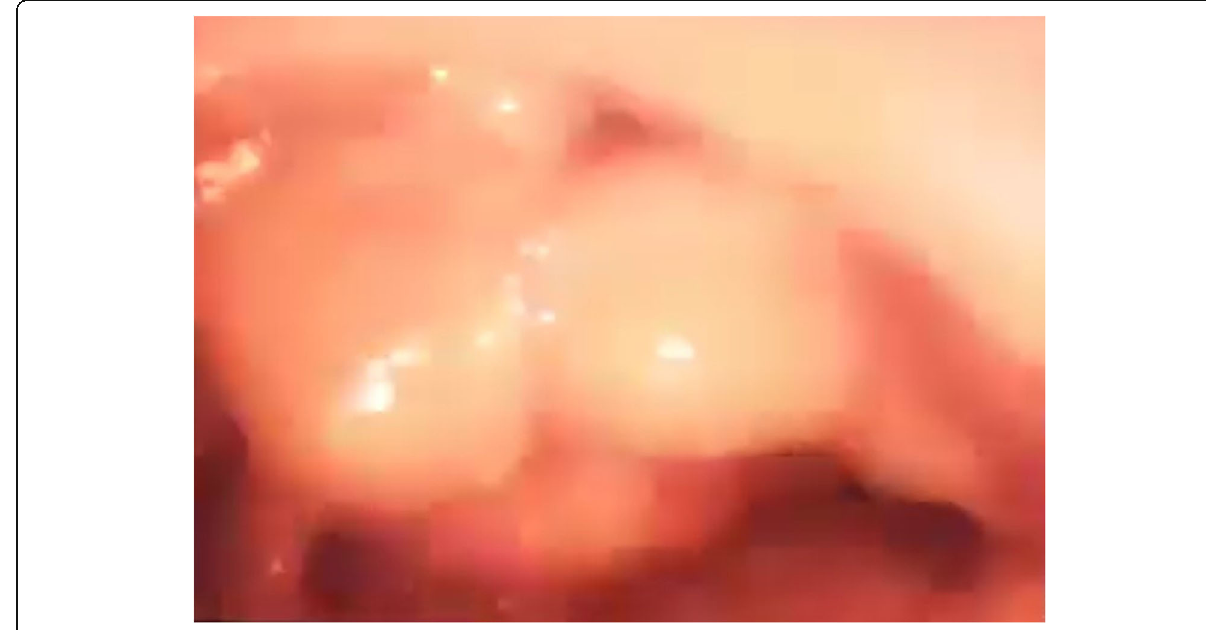
Fig. 2 Growth seen in the per laryngeal area with laryngeal and esophageal